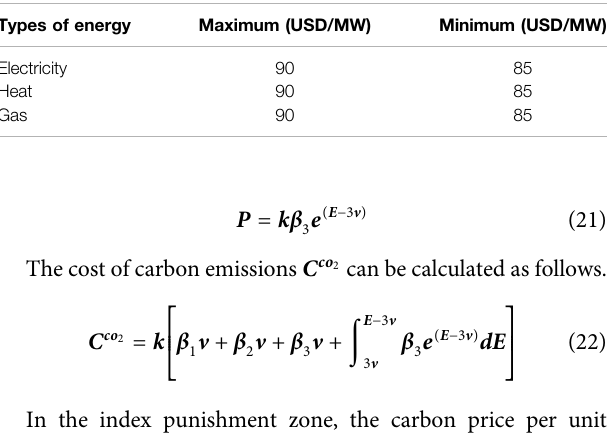
TABLE 1 | Supply agents ’ price limit. TABLE 2 | Service agents ’ price